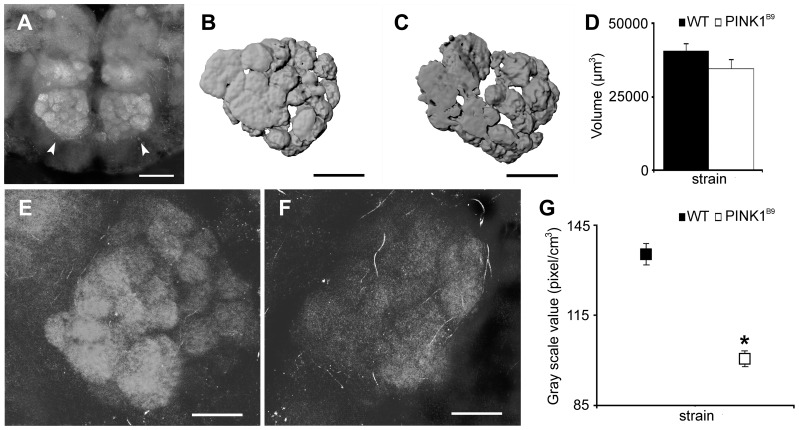
The antennal lobes reveal abnormalities in PINK1B9 mutants.ALs were stained for the expression of Bruchpilot protein. Panel A: Confocal micrographs of a frontal view of a couple of ALs (indicated by the arrow heads), with their well-defined glomeruli in WT and the mutant (Scale bar = 50 µm). B,C: The volume rendering for the monoclonal nc82 antibody-stained AL as seen from a frontal view in a WT (B) and in a PINK1B9 mutant (C) (scale bars = 30 µm). Ten specimens in the age range of 3–10 days for each strain were analyzed; the volumes measured were averaged and the statistical differences evaluated. Mean values ± S.E. are reported in C: no significant difference was detected (P>0.05). E,F: Higher magnification photomicrographs of a single AL in WT and PINK1B9 mutant respectively (scale bars = 20 µm). The latter reproducibly displays a less intensive staining and the glomeruli are not as clearly defined as in the WT. The gray scale value, taken as the index of intensity, was measured on ALs from binarized stacks of images (n = 10 for each strain). Mean values ± S.E. for both WT and PINK1B9 mutants are shown in G. Statistical evaluation of the data shows that the staining intensity in PINK1B9 is significantly lower compared to WT; (*significantly different from its matching value; P<0.05).